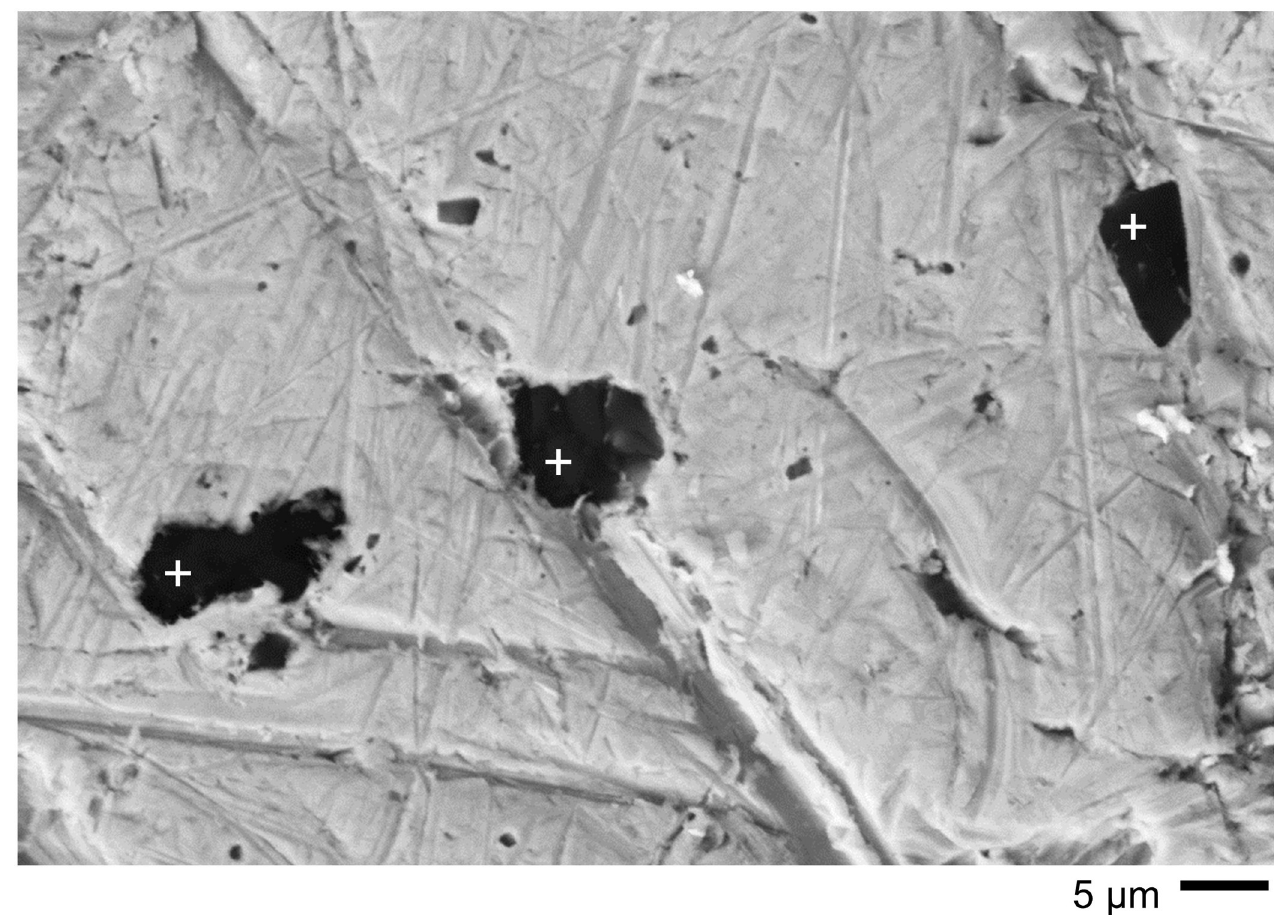
Fig 10. Examples of small patches on the surface of coin GLAHM:40333 by SEM. The spots analysed (crosses) all indicated the presence of Si and O with minor contributions of Au from the underlying metal, suggesting that such patches are cementation spots composed of opaline silica. The three spectra (given in S3 File with data in S4 File) show Si = 46 +/-1.2 wt% and O = 54 +/- 1.2 wt%, consistent with silica.